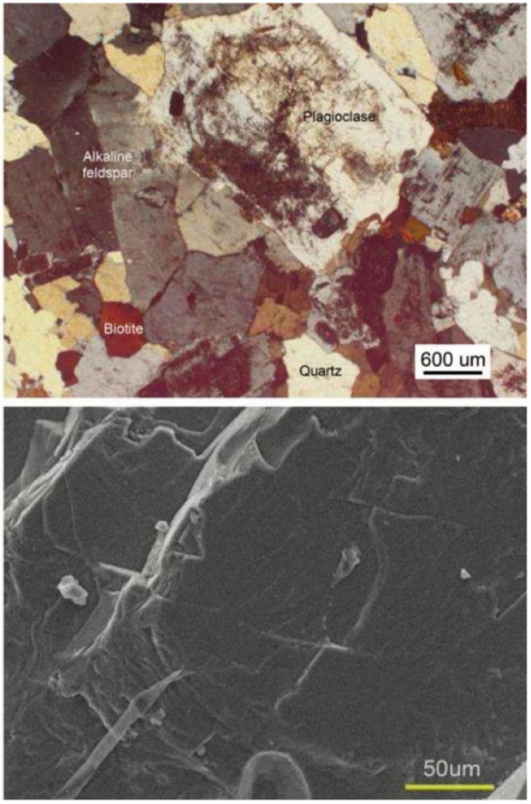
Figure 3. Observations of medium-grained monzogranite at different